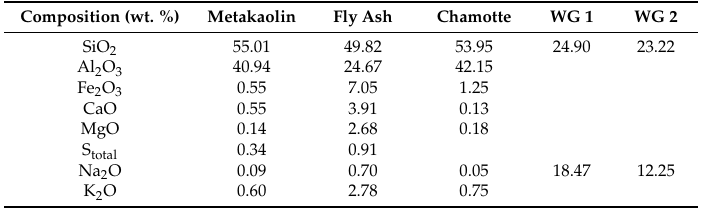
Table 1. Chemical compositions of the materials used in the